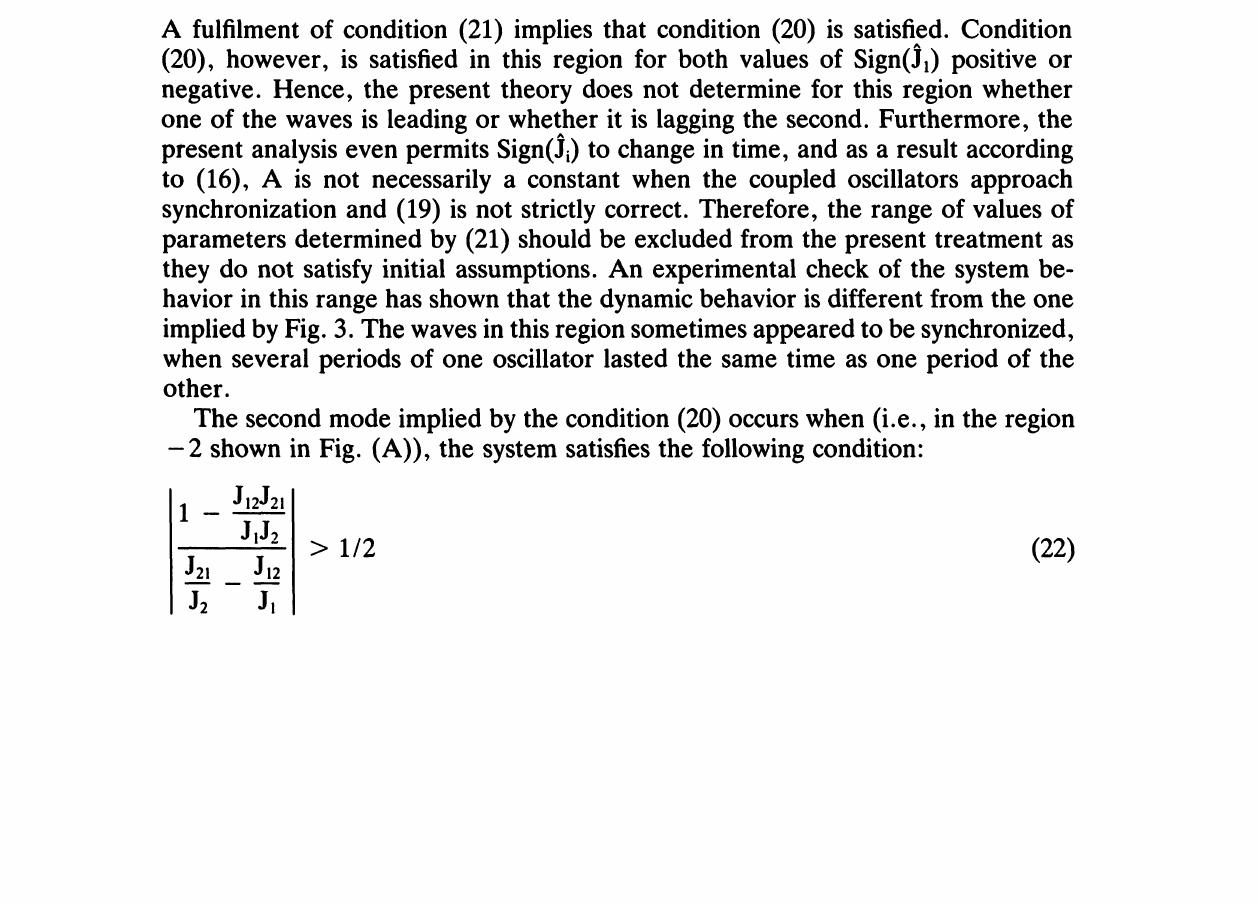
CASE ]mwhen sign CASE llmwhen sign Ji -1, i.e.,